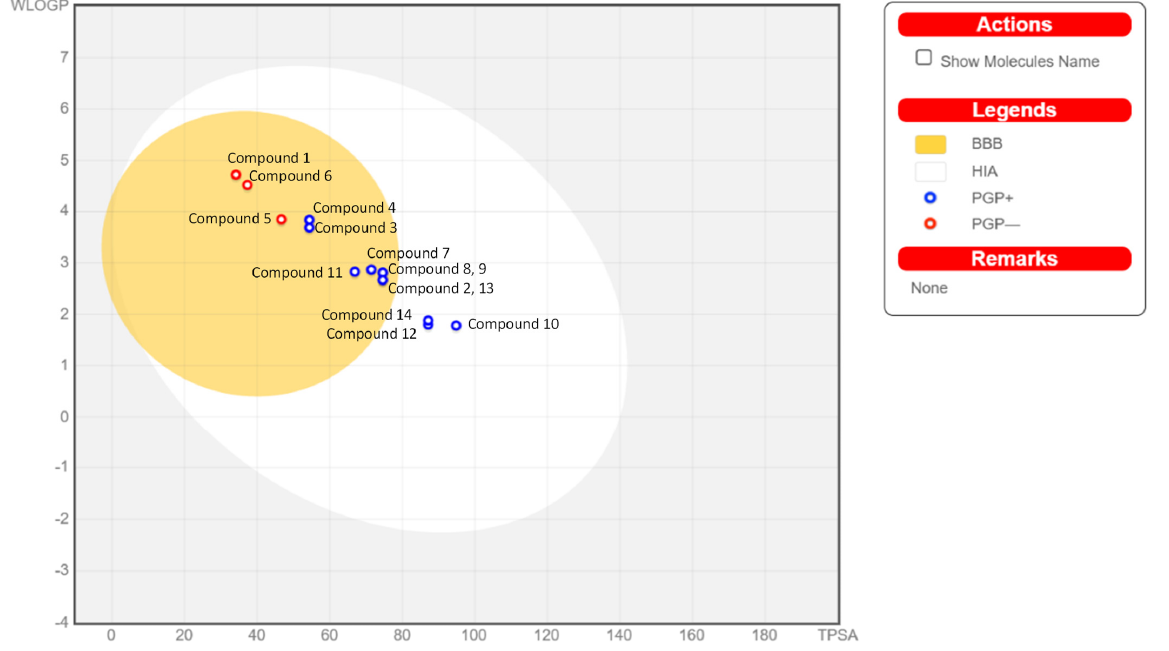
Figure 7. BOILED-Egg analysis (described in the